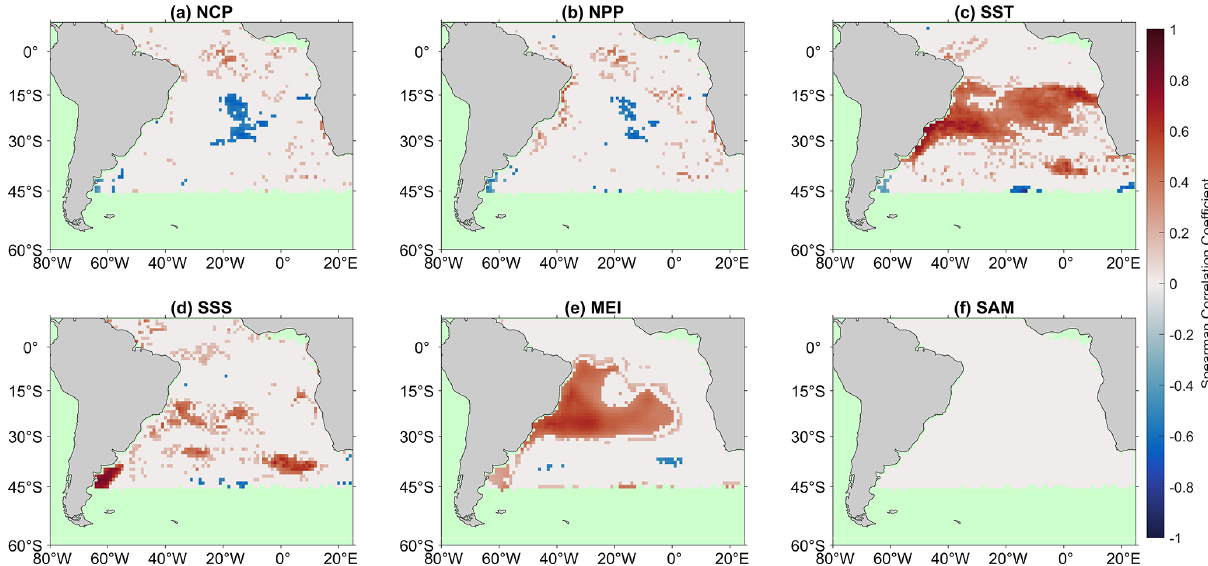
Figure 3. Significant Spearman correlations between the (cid:49)p CO 2 inter-annual component of the X-11 analysis and (a) net community production (NCP), (b) net primary production (NPP), (c) sea surface temperature (SST), (d) sea surface salinity (SSS), (e) multivariate ENSO index (MEI), and (f) Southern Annular Mode (SAM) inter-annual components. White regions indicate no significant correlations, and green regions indicate no analysis was performed due to missing satellite